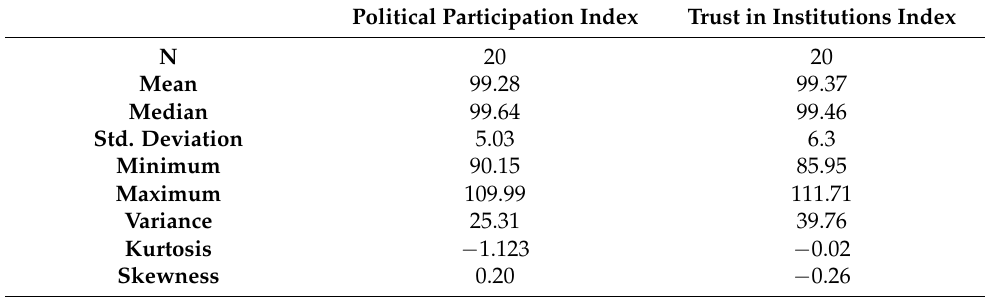
Table 6. Descriptive statistics.